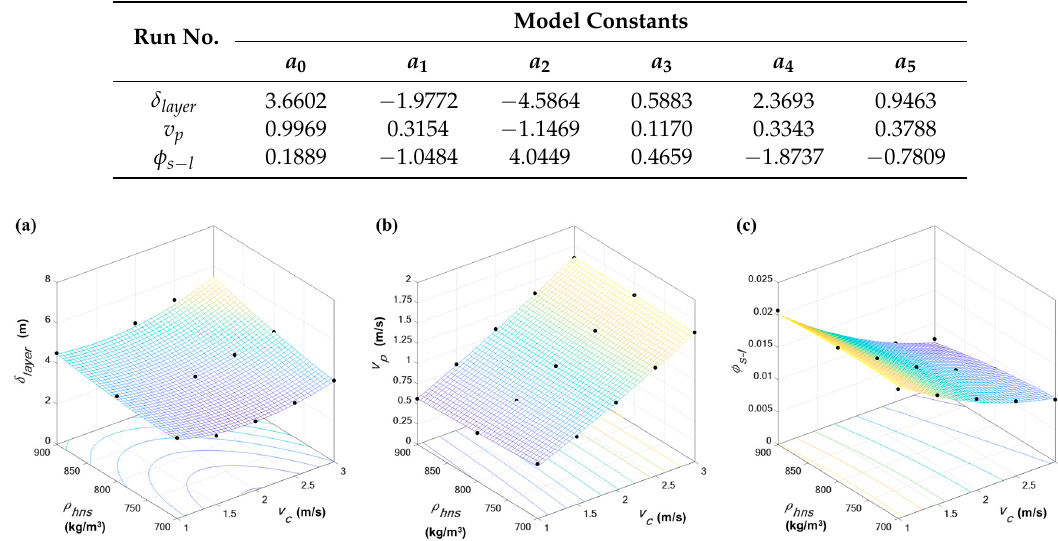
Figure 8. Three-dimensional contours of ( a ) HNS layer thickness, ( b ) HNS propagation velocity at sea level, and ( c ) averaged HNS mass fraction. Table 2. Error testing of response surface Table 1. Model constant of second-order response surface model (RSM). Run No.